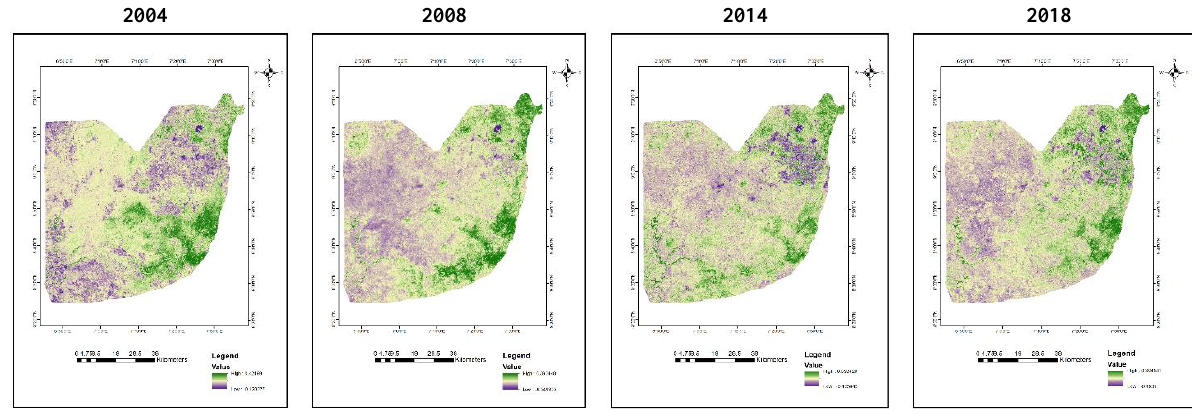
Figure 4. Spatial distribution of the NDVI in 2004, 2008, 2014 and